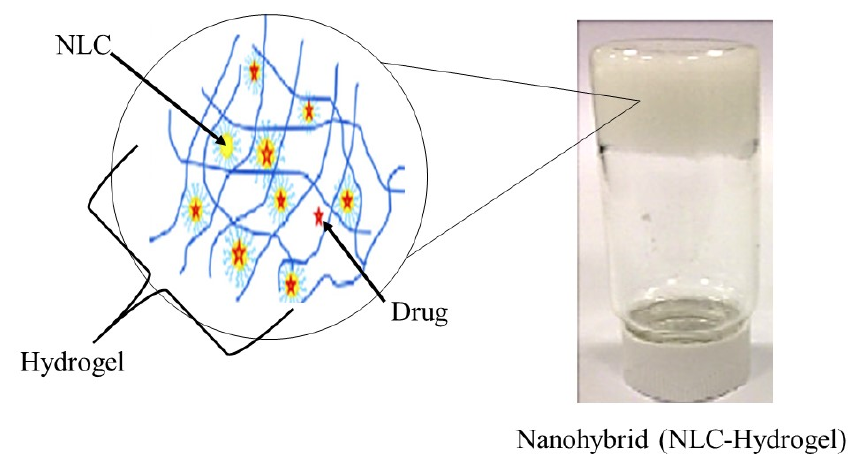
Figure 3. Structural view of nanohybrid system (NLC-Hydrogel) (created and modified with biorender.com (accessed on 2 October 2021) and adapted from [89]).